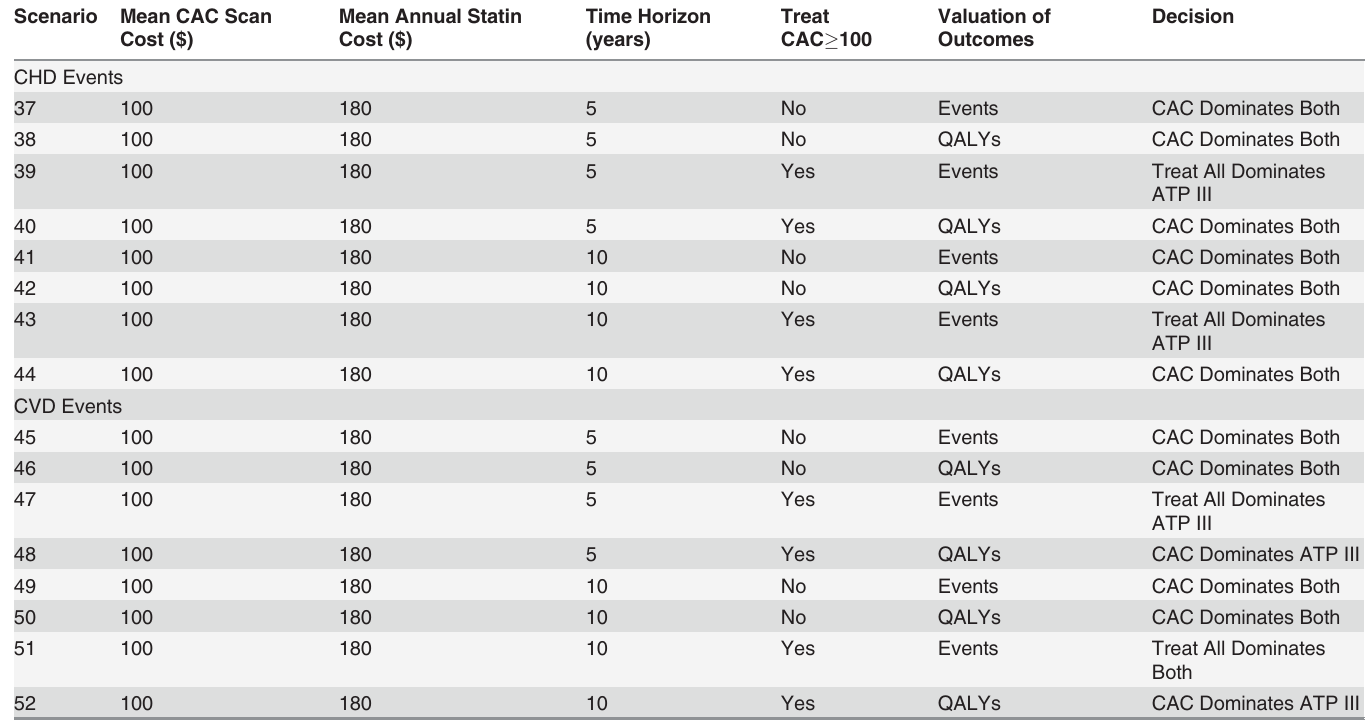
Table 5. Sensitivity Analysis on Event Rate Parameters — 2x MESA Event